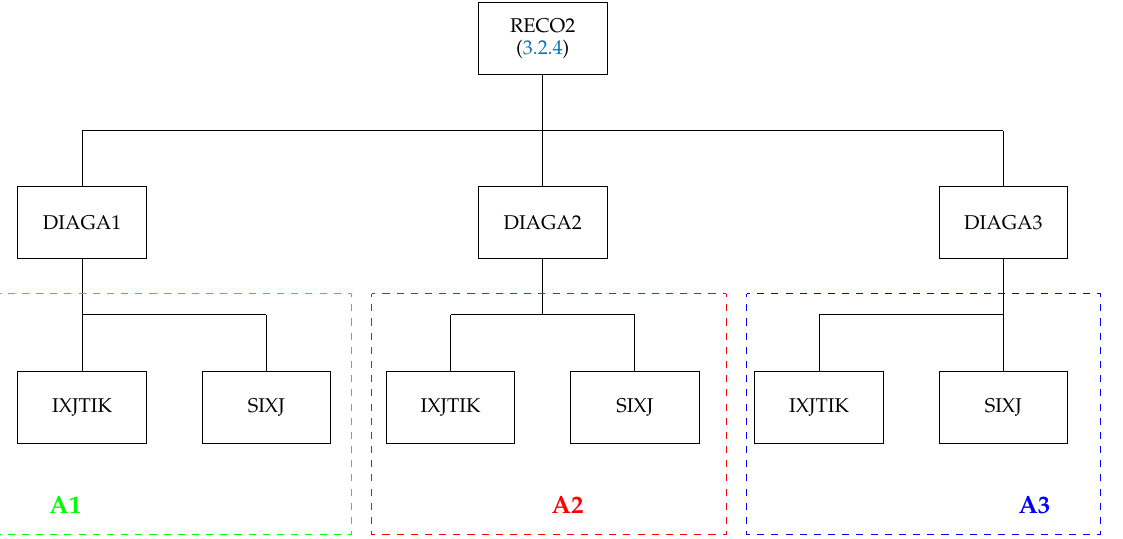
Figure 10. Structure of the subroutine RECO2 . The green frame A1 shows the structure of the routine DIAGA1 , the red frame A2 shows the structure of the routine DIAGA2 , and the blue frame A3 shows the structure of the routine DIAGA3 to which the subroutine RECO2 explicitly is